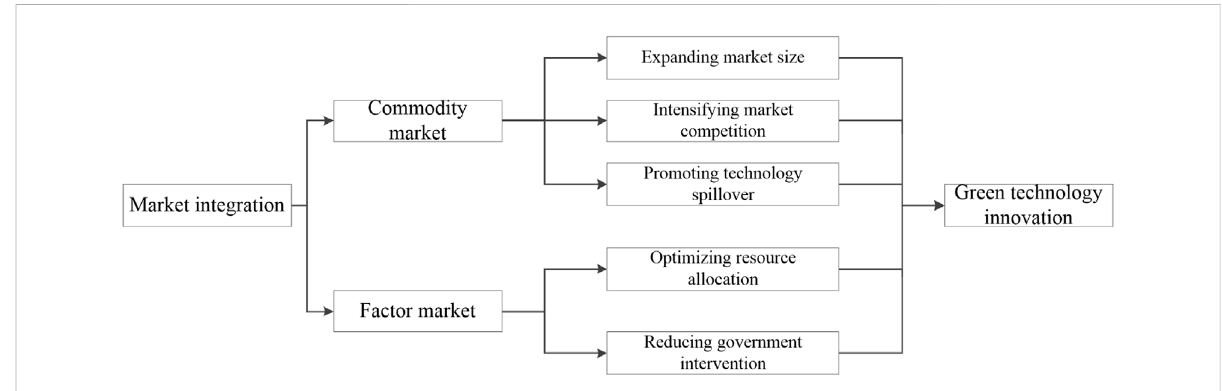
FIGURE 1 Theoretical framework for the impact of market integration on green technology